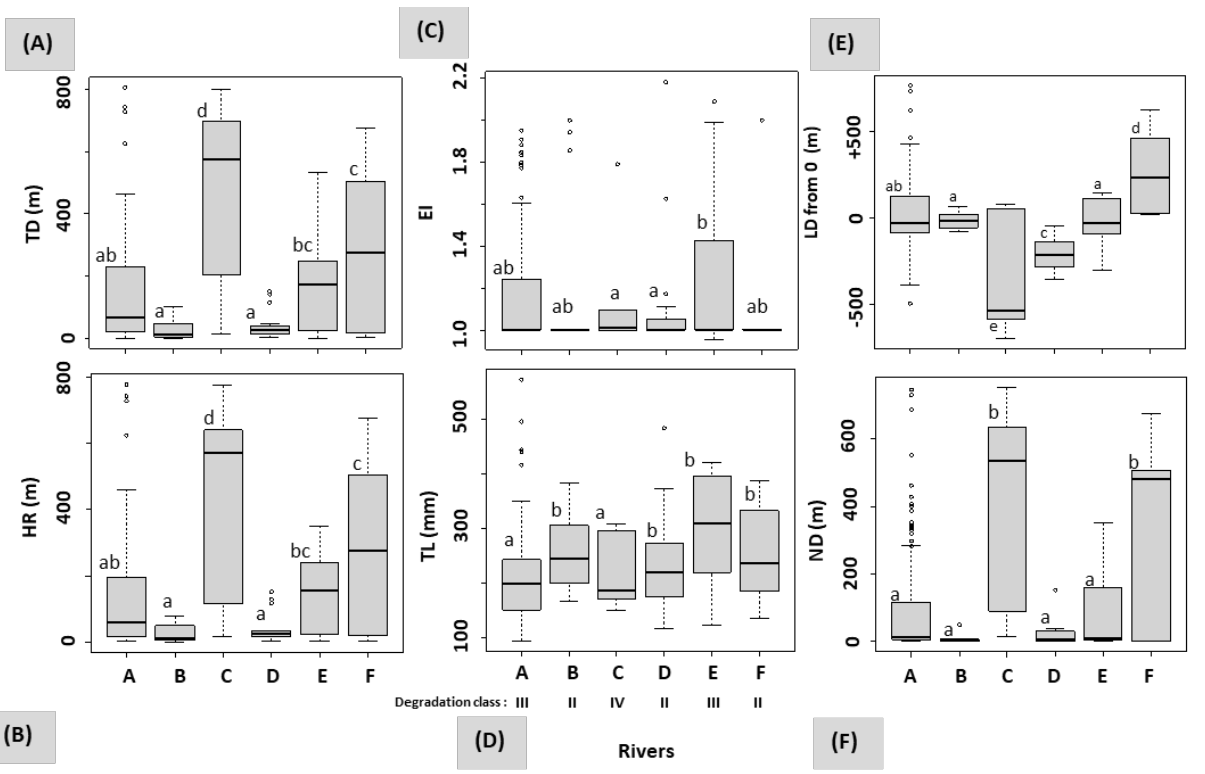
Figure 5. The total distance travelled (TD) ( A ), the home range (HR) ( B ) and the exploitation index (EI) ( C ) of the HR in eels 5 + (based on the spring 2022 telemetry session) according to the rivers. Longitudinal dispersal (LD) ( E ) during the 2022 session, net distance travelled (ND) ( F ) under flood events and the total length (TL) ( D ) of eels at tagging. n indicates number of eels 5 + . The rivers are A ( n = 93), B ( n = 14), C ( n = 6), D ( n = 15), E ( n = 25) and F ( n = 6). For ND, the numbers are 86 for river A , 12 for river B , 6 for river C , 10 for river D , 16 for river E and 5 for river F . Boxplots are presented with median values; the hinges indicate the first and third quartiles and the circles indicate outliers. Rivers sharing the same letter are not significantly different (Kruskal–Wallis test followed by Dunn’s test: p <